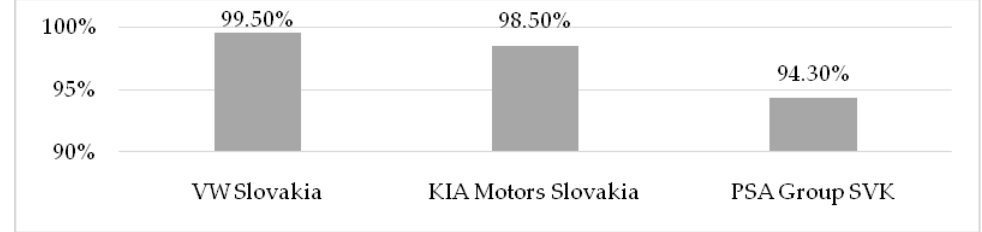
Figure 2. Shares of exports in sales of selected car manufacturers in 2017 (%). Source: Authors’ compilation. In terms of the territorial structure of Slovak passenger car exports (2017), Slovakia had the highest share of exports to Germany (15.20%; 2,227,301 euros), follow not far behind by